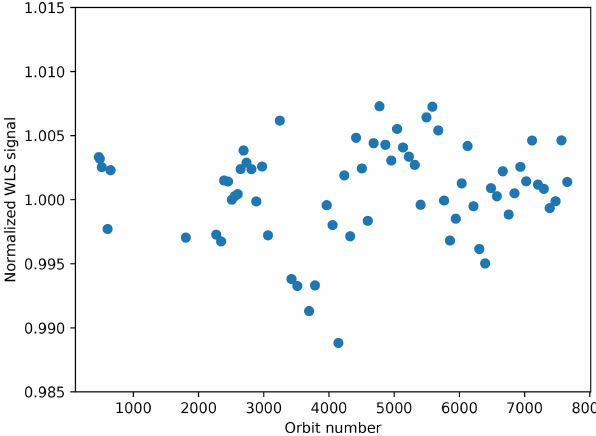
Figure 25. Median normalized WLS signal as a function of time. Figure 26. Comparison between the ISRF measurements taken dur- ing the E1 phase and during nominal operations, both without an oscillating diffuser. Panel (a) shows the normalized pixel response in orbits 5396 (red) and 1667 (blue). The differences are plotted in green. Panel (b) shows a zoomed in section of the residuals.